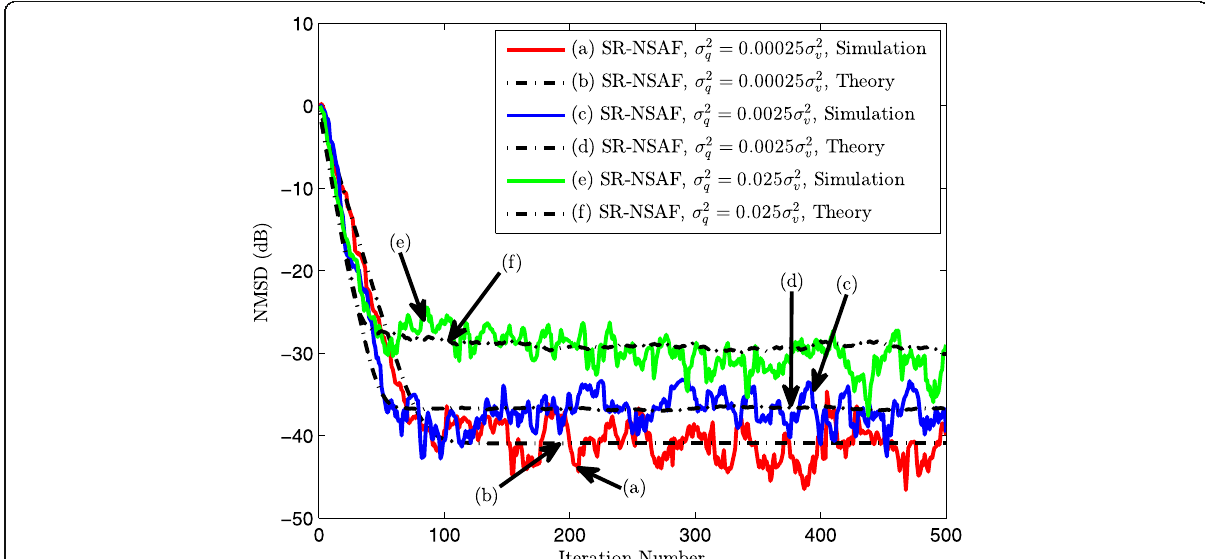
Fig. 28 Simulated and theoretical NMSD learning curves of SR-NSAF with N =8 and μ =0.5 in nonstationary environment for different values of σ 2